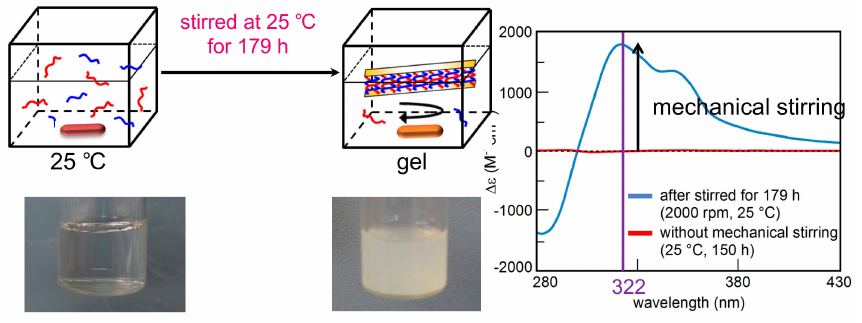
Figure 30. Formation of hetero-double-helices and self-assembly of oxymethylenehelicene ( M )-hexamer and ( P )-pentamer mixture in solution at 25 ◦ C by mechanical stirring. The changes are shown by visual images and CD